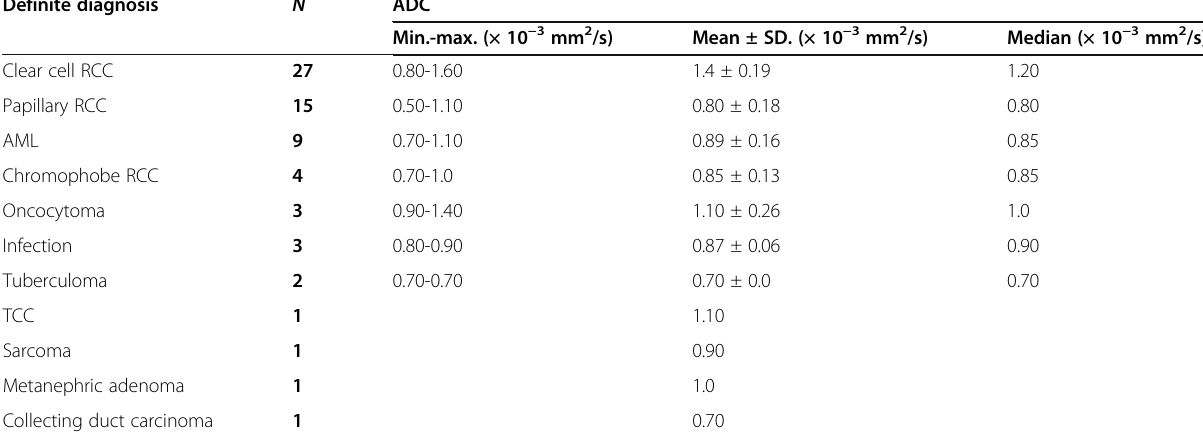
Table 2 Min., max., mean, and median ADC for different masses ( n = 67)